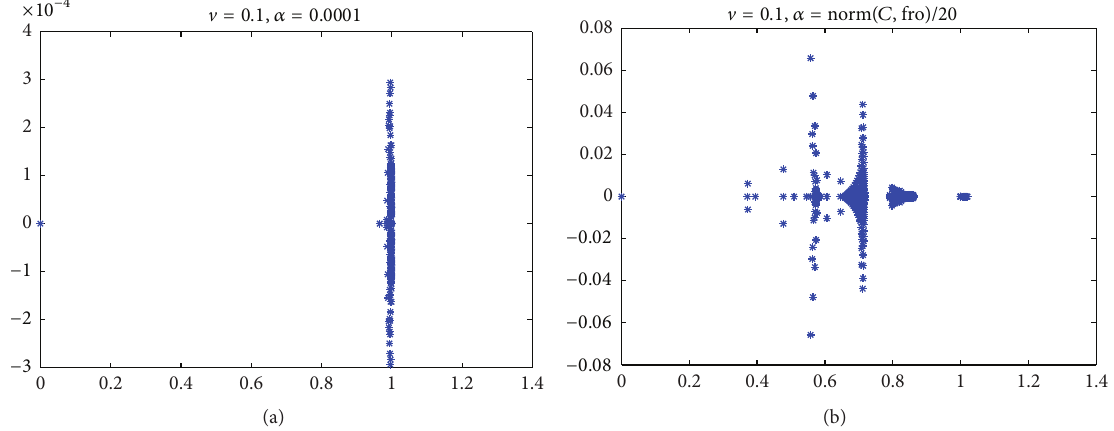
Figure 1: Spectrum of the preconditioned steady Oseen matrix with viscosity coefficient V = 0.1, 32 × 32 grid. (a) Q2-Q1 FEM, 𝐶 = 0 ; (b) Q1-P0 FEM, 𝐶 ̸=0 .